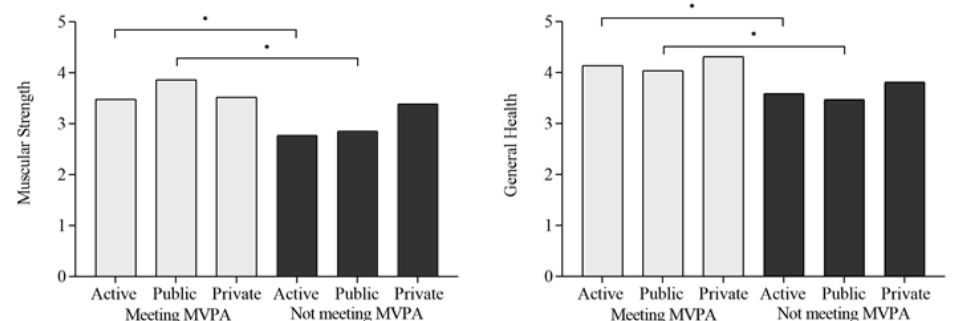
Figure 1. Associations of mode of commuting and meeting MVPA recommendations with fitness in men. Notes: active, public, private = mode of commuting; MVPA = Moderate to Vigorous Physical Activity; Meeting or Not meeting MVPA = MVPA recommendations; * = significant association with p < 0.05 between categorical groups.